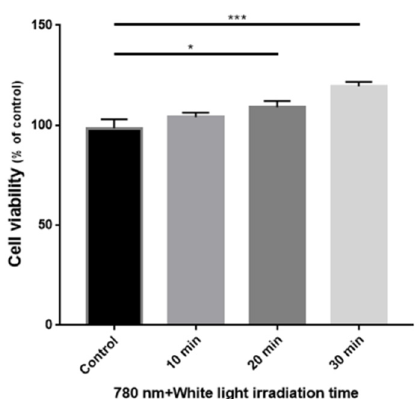
Figure 6. Signal-to-background ratio (SBR) measurements. SBR are measured in different of gain, exposure time, and concentrations of ICG solution. Each line in the caption describes the concentra- tion of the ICG solution.